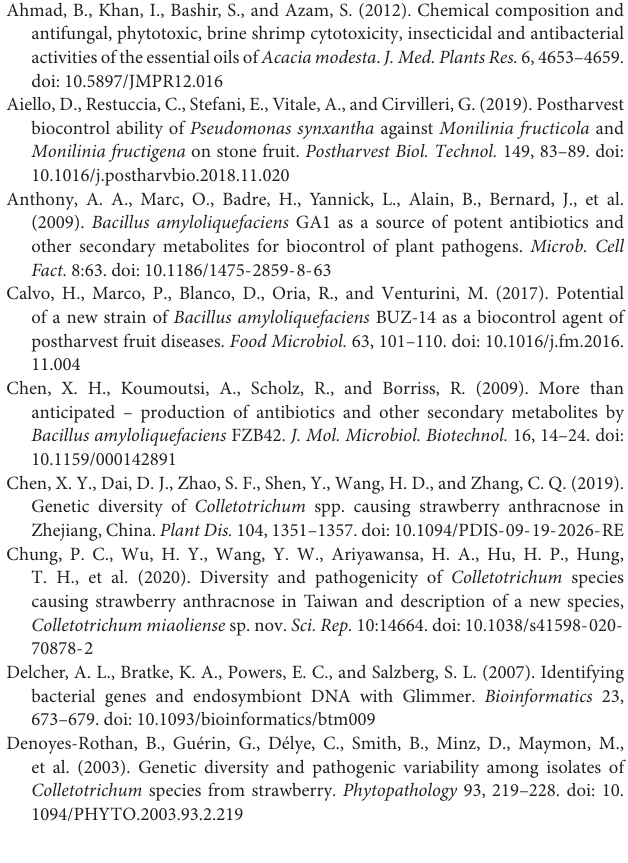
Supplementary Figure 1 | Hemolytic activity of red blood cells treated with strain QN1NO-4 extract. Supplementary Figure 2 | Genome annotation of strain QN1NO-4. Supplementary Figure 3 | Genome-wide analysis of gene clusters related to the biosynthesis of secondary metabolites in the strain QN1NO-4 genome using the online antiSMASH v4.2.0 software.